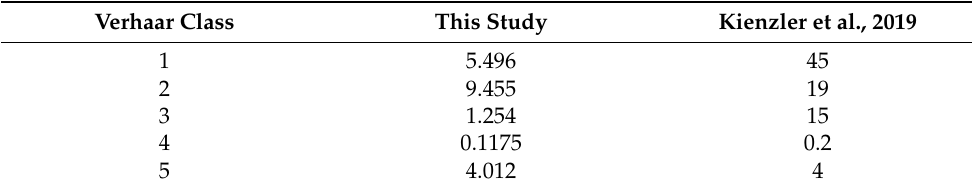
Table 4. Comparison of the eco-TTCs in this work with those obtained by Kienzler et al., 2019. Values are ng/L. Verhaar Class This Study Kienzler et al.,